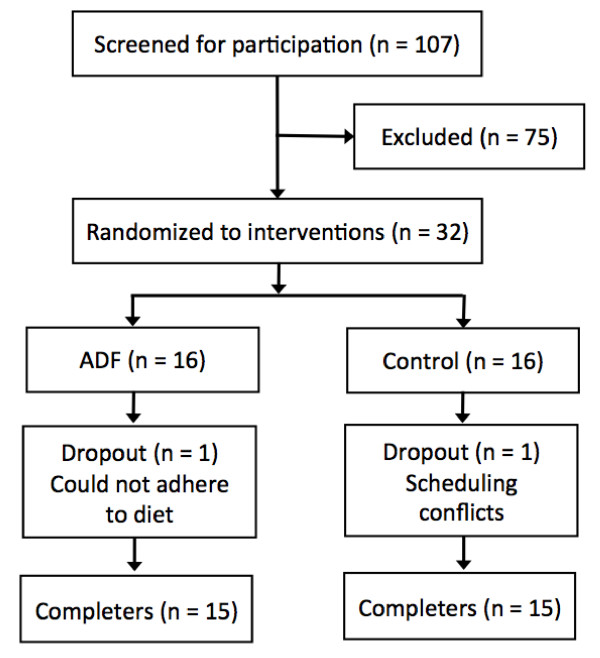
Study flow chart. ADF: Alternate day fasting.